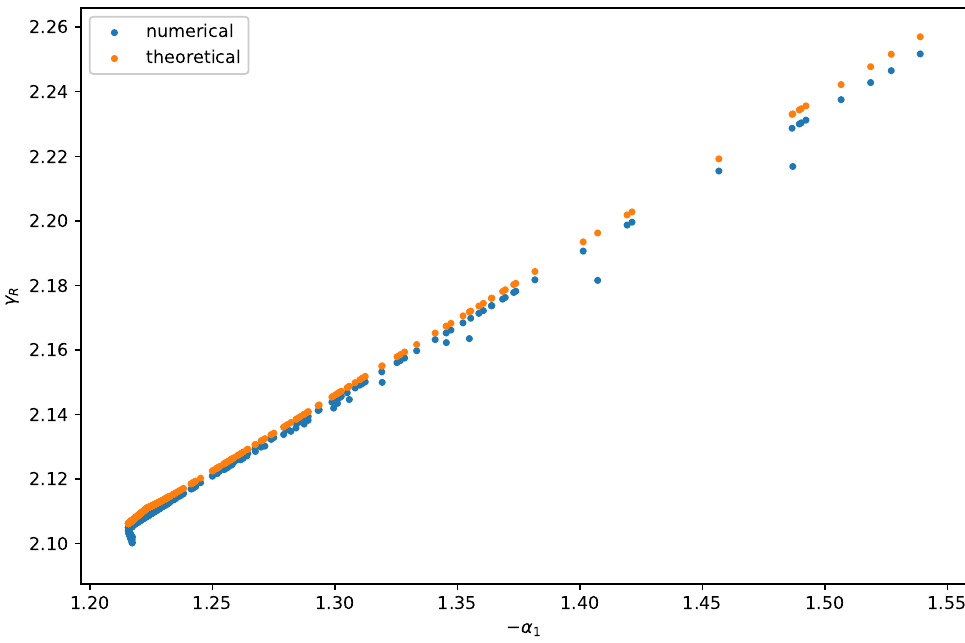
Figure 3 . Theoretical upper bound (orange) and numerical results (blue) versus − α 1 ( x -axis) with the fixed parameters γ ( j ) = − 0 . 0884 and θ ( j ) = 0 . 00238 2